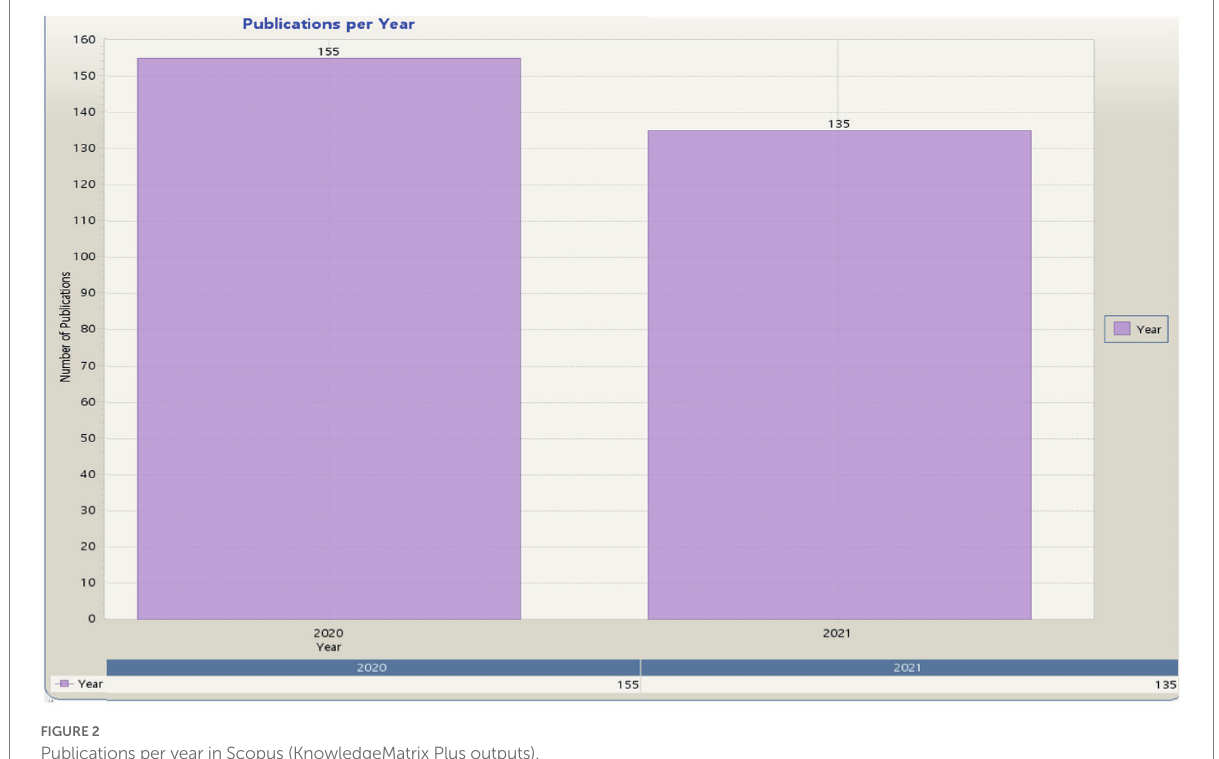
FIGURE 2 Publications per year in Scopus (KnowledgeMatrix Plus outputs).